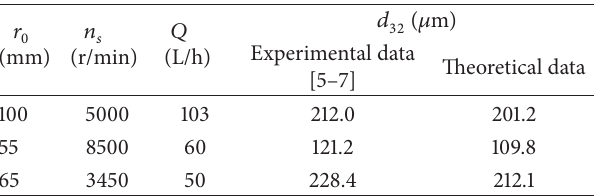
Figure 17: Rotating disk ligament number analysis test facility. 1: power; 2: air circuit breaker; 3: inverter; 4: variable frequency motor; 5: diaphragm coupling; 6: rotational disk; 7: photography lights; 8: high speed camera; 9: computer; 10: thermometer; 11: pressure gage 12: flow control valve; 13: volumetric flow meter; 14: pressure reducing valve; 15: check valve; 16: stop valve; 17: relief valve; 18: oil pump; 19: motor; 20: level gauge; 21: filter; 22: oil heater; 23: oil reservoir; 24: thermocouple; 25: temperature controller. Table 3: Comparison of theoretical and experimental oil droplet